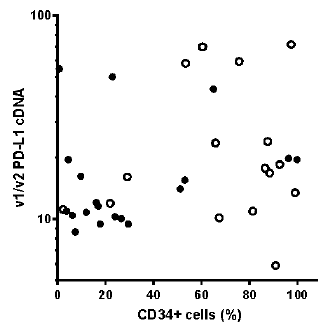
Figure 6. PD-L1 positivity versus CD34-positive cell fraction in leukemia blasts. PD-L1 v1 / v2 cDNA levels as a function of CD34-positive cell fraction in samples with the wild-type (empty symbols) or mutated (closed symbols) NPM1 .